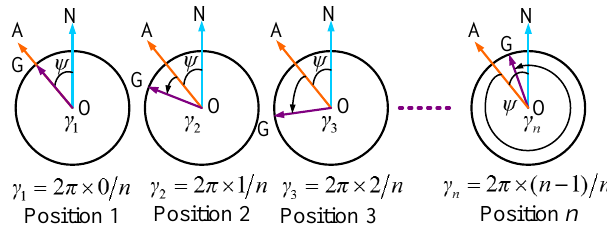
Figure 2. The gyro north finder multi-position non-continuous rotation scheme. The non-continuous rotation scheme samples specify the gyro outputs at appointed